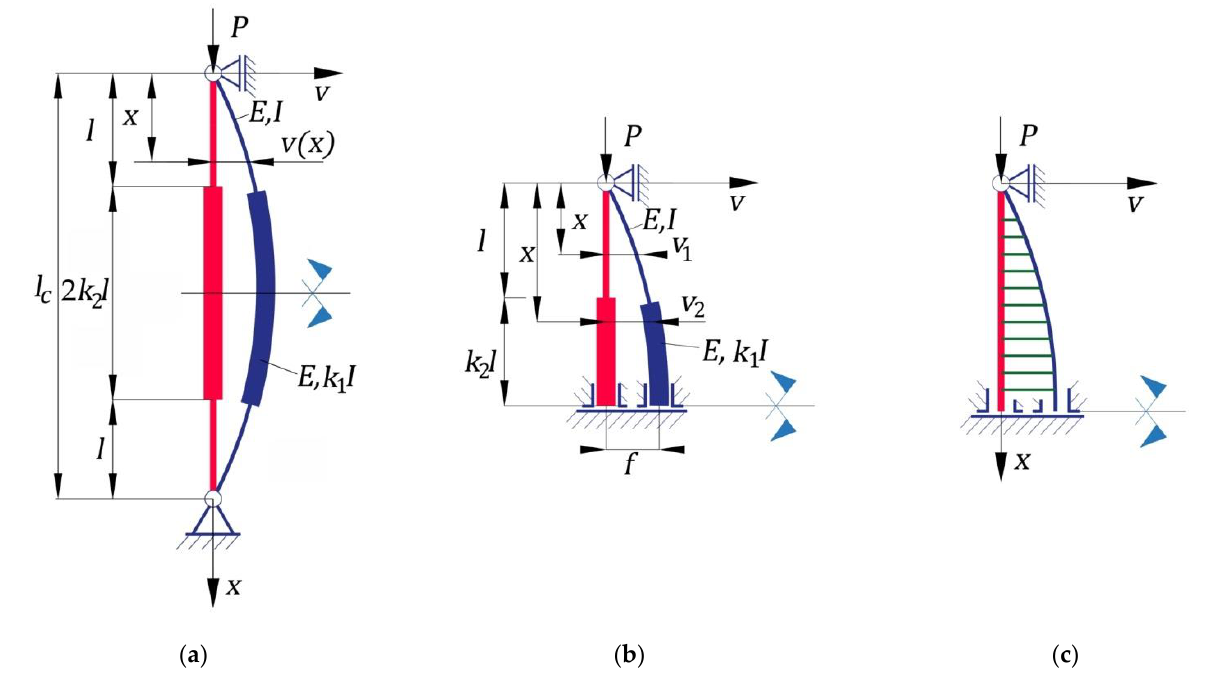
Figure 1. Bar analyzed having a stepwise variable cross-section whose bottom end is pin-connected, while the upper end is simply supported: ( a ) geometrical model of the entire bar and deformed shape at stability loss; ( b ) geometrical model considering the symmetry condition; ( c ) bending-moment diagram.